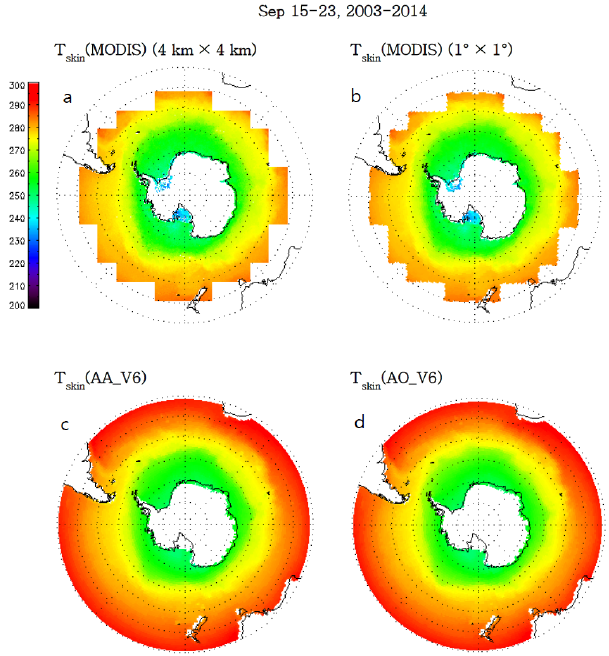
Figure 1. (a) 12-year composite skin temperatures (K) of the MODIS IST over the Southern Hemisphere during 15–23 Septem- ber 2003–2014. The original MODIS data (MYD29E1D) have a 4km × 4km spatial resolution. Their spatial resolution has been re- constructed to 1 ◦ × 1 ◦ in (b) in order to compare this data with the AIRS/AMSU data. (c) – (d) is the surface skin temperatures of the AIRS/AMSU and AIRS only over the Southern Hemisphere ocean during 15–23 September 2003–2014,